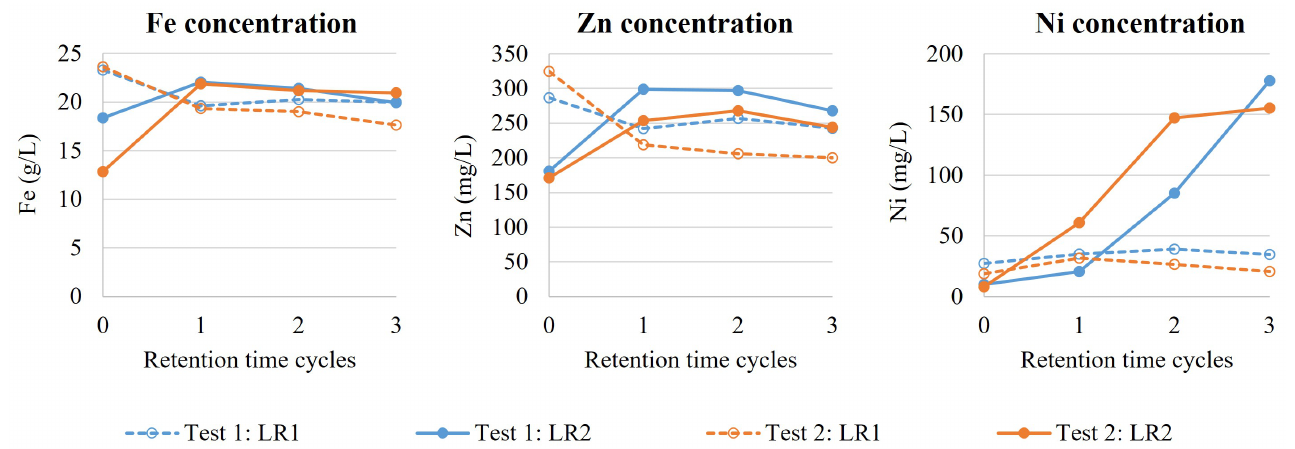
Figure 4. Concentration of Fe, Zn and Ni in continuous mode tests. LR1 = the first leaching reactor, LR2 = the second leaching reactor.